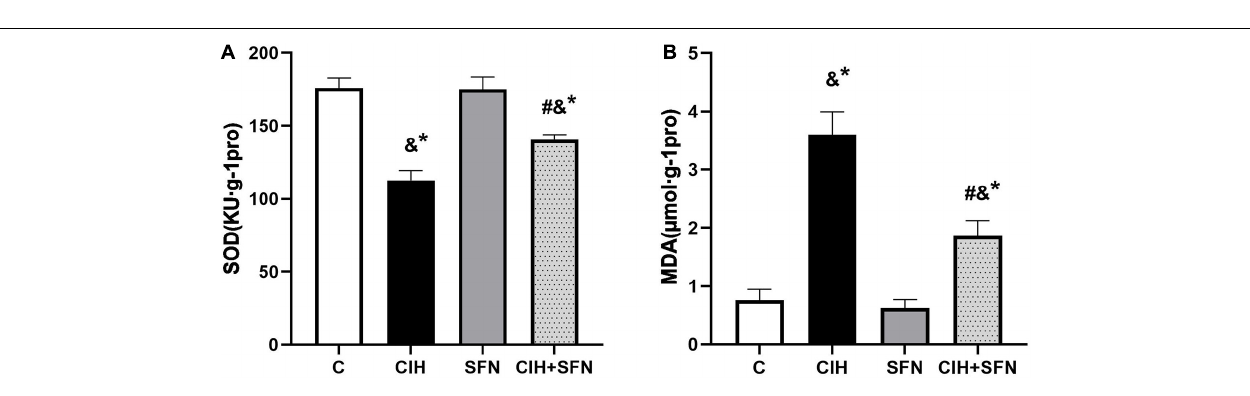
Frontiers in Cellular Neuroscience |